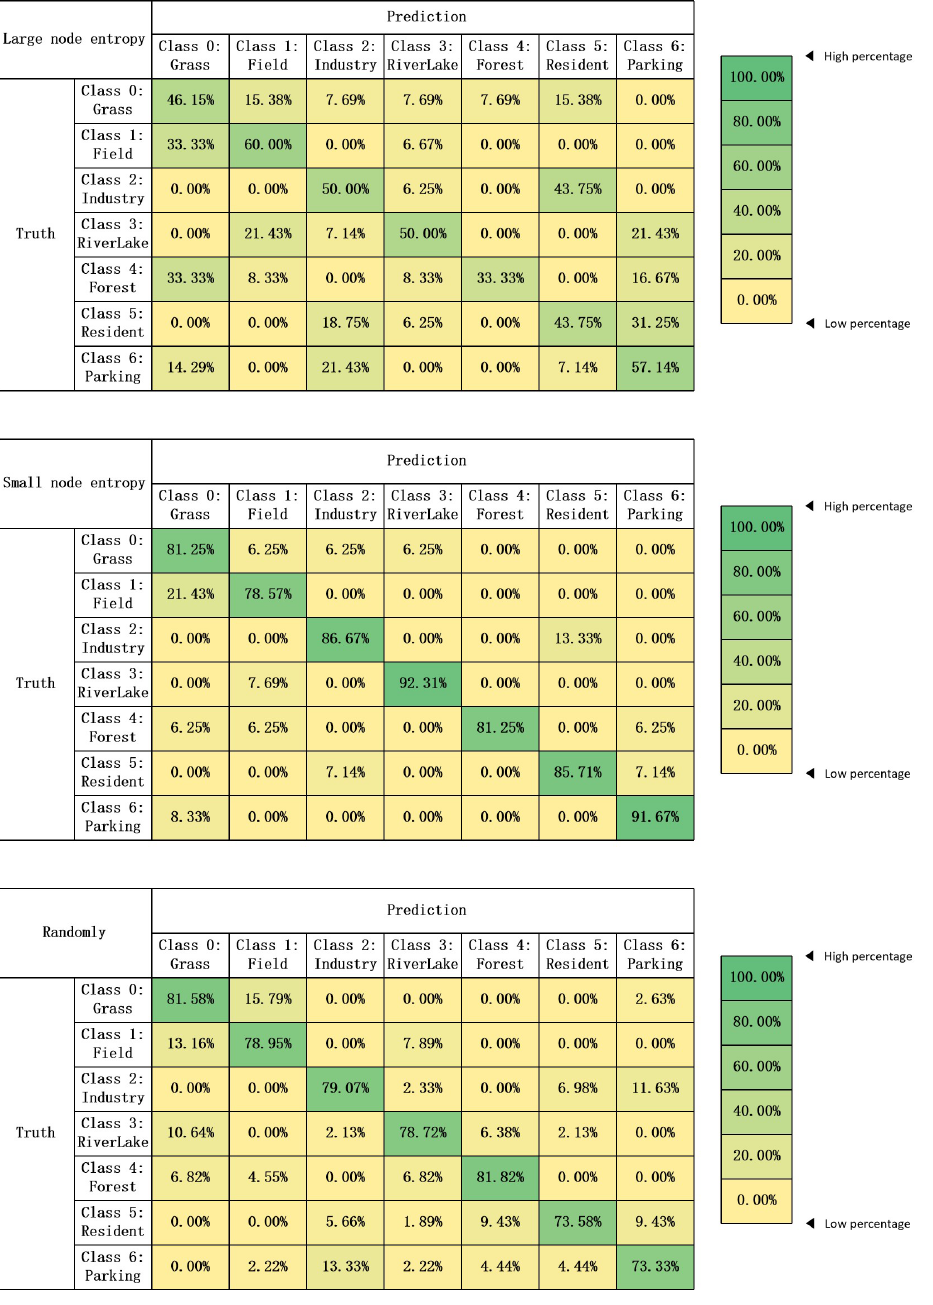
Figure 7. The test results of 100 images with large node entropy, 100 images with small node entropy, and 100 images randomly selected from the RSSCN7 unlabeled